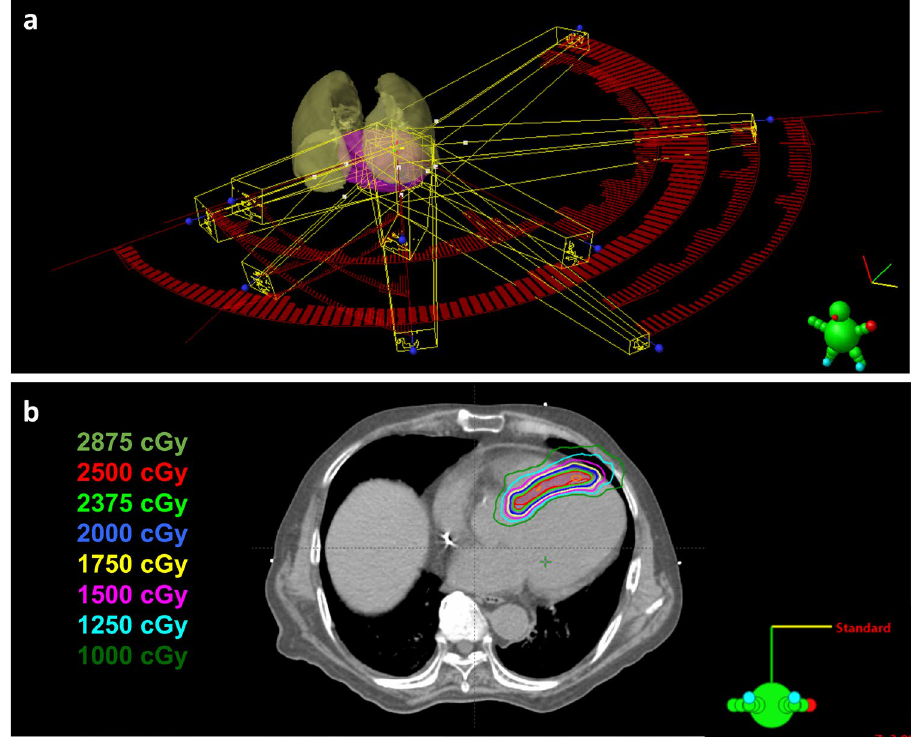
Figure 2. Noninvasive cardiac radioablation beam arrangement and isodose distributions. Patient 7 underwent noninvasive cardiac radioablation via 6 MV flattening filter-free photon beam and stereotactic volumetric modulated arc radiotherapy technique. A total of 25 Gy was prescribed to internal target volume (ITV) and 20 Gy to planning target volume (PTV) in a single fraction by simultaneous integrated boost strategy. Shown are ( a ) beam arrangement in noninvasive cardiac radioablation plan, and ( b ) dose distributions on the axial view. The colorwashed areas indicate the following: red, the ITV; and blue, the PTV. The orange, red, light green, blue, yellow, pink, indigo, and dark green lines represent isodose curves of 2875, 2500, 2375, 2000, 1750, 1500, 1250, and 1000 Gy, respectively. The radioablation dose distribution figure was created by using treatment planning system (version 15.6, Eclipse, Varian Medical Systems, Palo Alto, URL: http:// www. MyVar ian.